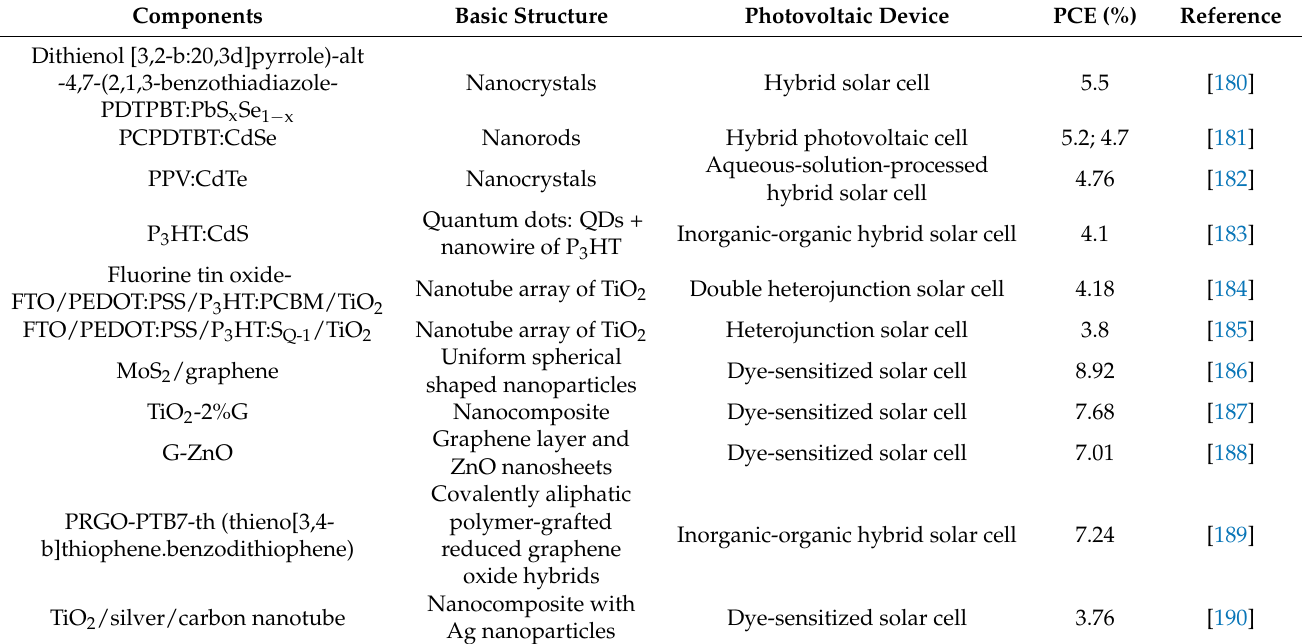
Table 6. Photovoltaic nanocomposites as electrodes, basic structures, and efficiency. Components Basic